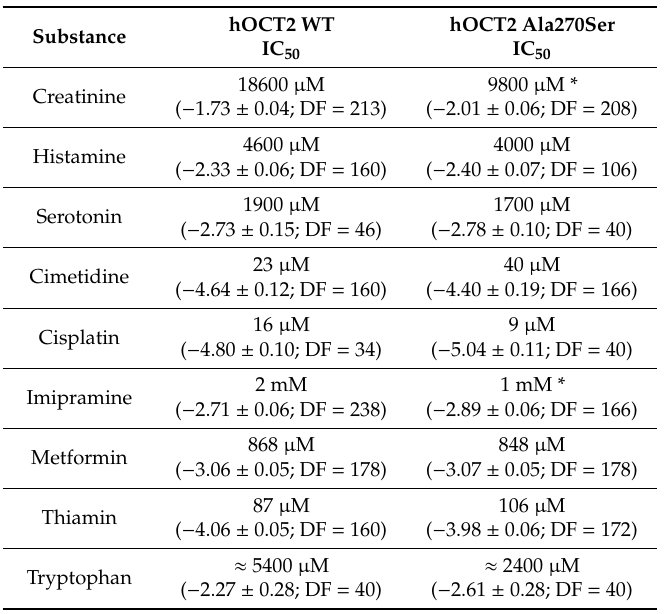
Table 1. Summary of apparent a ffi nities (IC 50 in µ M) measured as inhibition of ASP + uptake by hOCT2 WT and hOCT2Ala270Ser using di ff erent endogenous and exogenous substances as competitor. The logIC 50 ± SEM is shown in parenthesis with the degrees of freedom (DF).